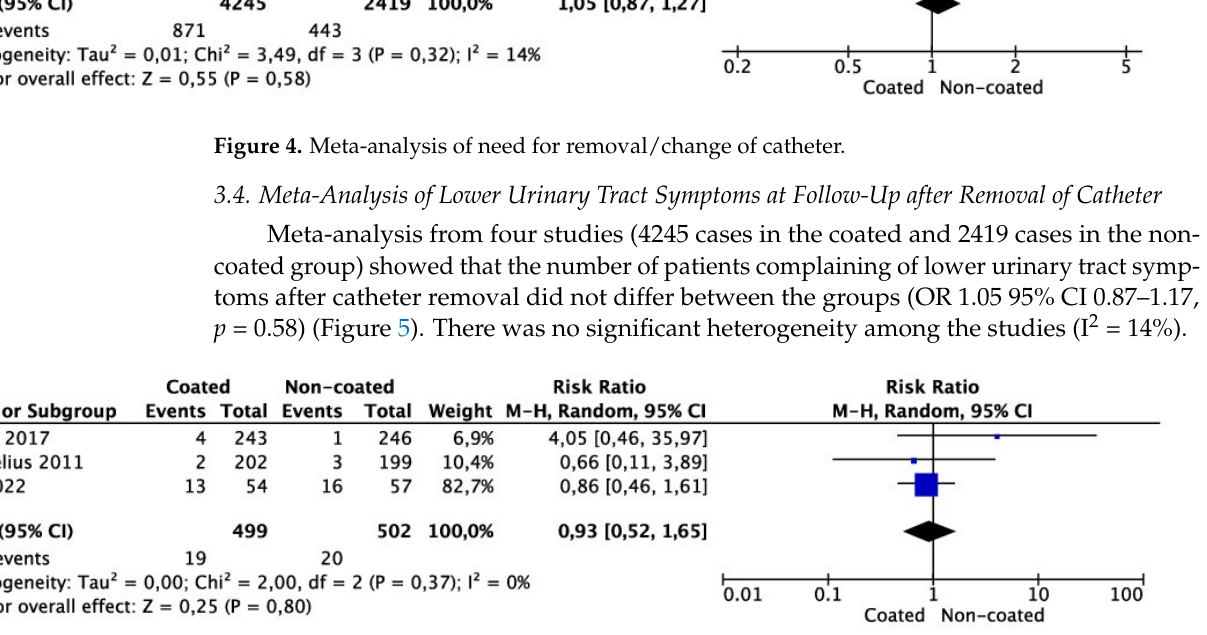
Figure 4. Meta-analysis of need for removal/change of catheter.